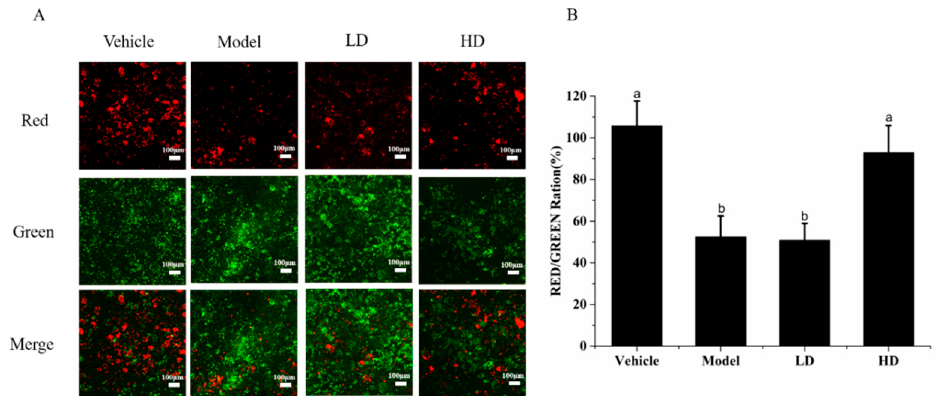
Figure 4. Effects of SAVEP on RAW264.7 cell mitochondrial membrane potential (MMP) of LPS-induced inflammatory injury. ( A ) Fluorescence intensity was observed by fluorescence microscope. ( B ) Fluorescence intensity of red/green ratio. Statistical analysis was performed using a one-way ANOVA with Tukey’s test. Data represent the mean ± SD ( n = 6). Different letters represent significant differences between groups ( p < 0.05). A larger version of ( A ) is shown in Figure S3.